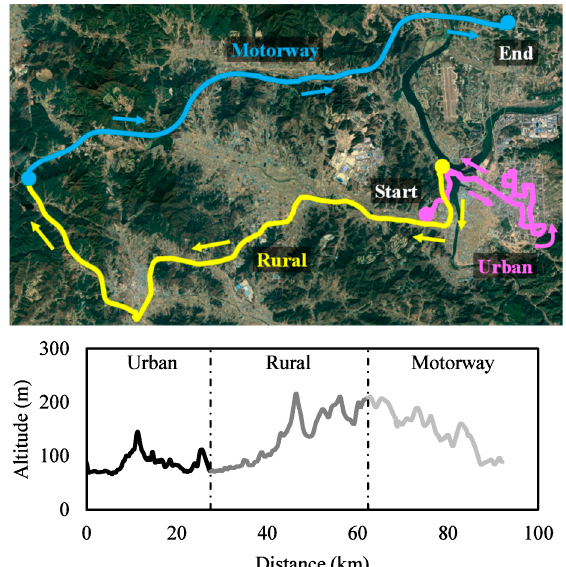
Figure 1. Real driving test route and